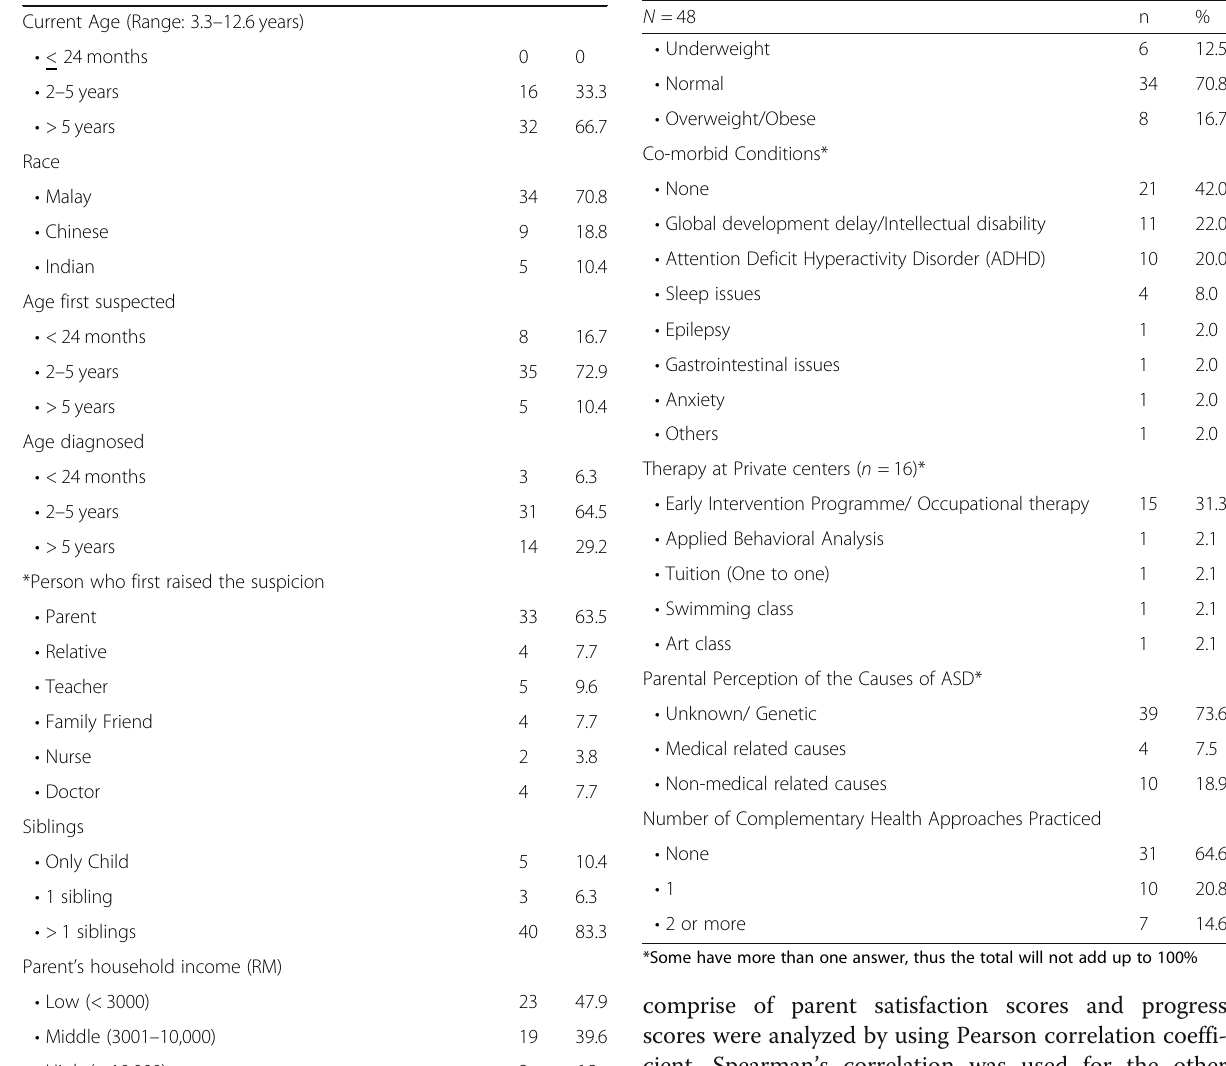
Table 1 Characteristics of Parents and their Children with ASD